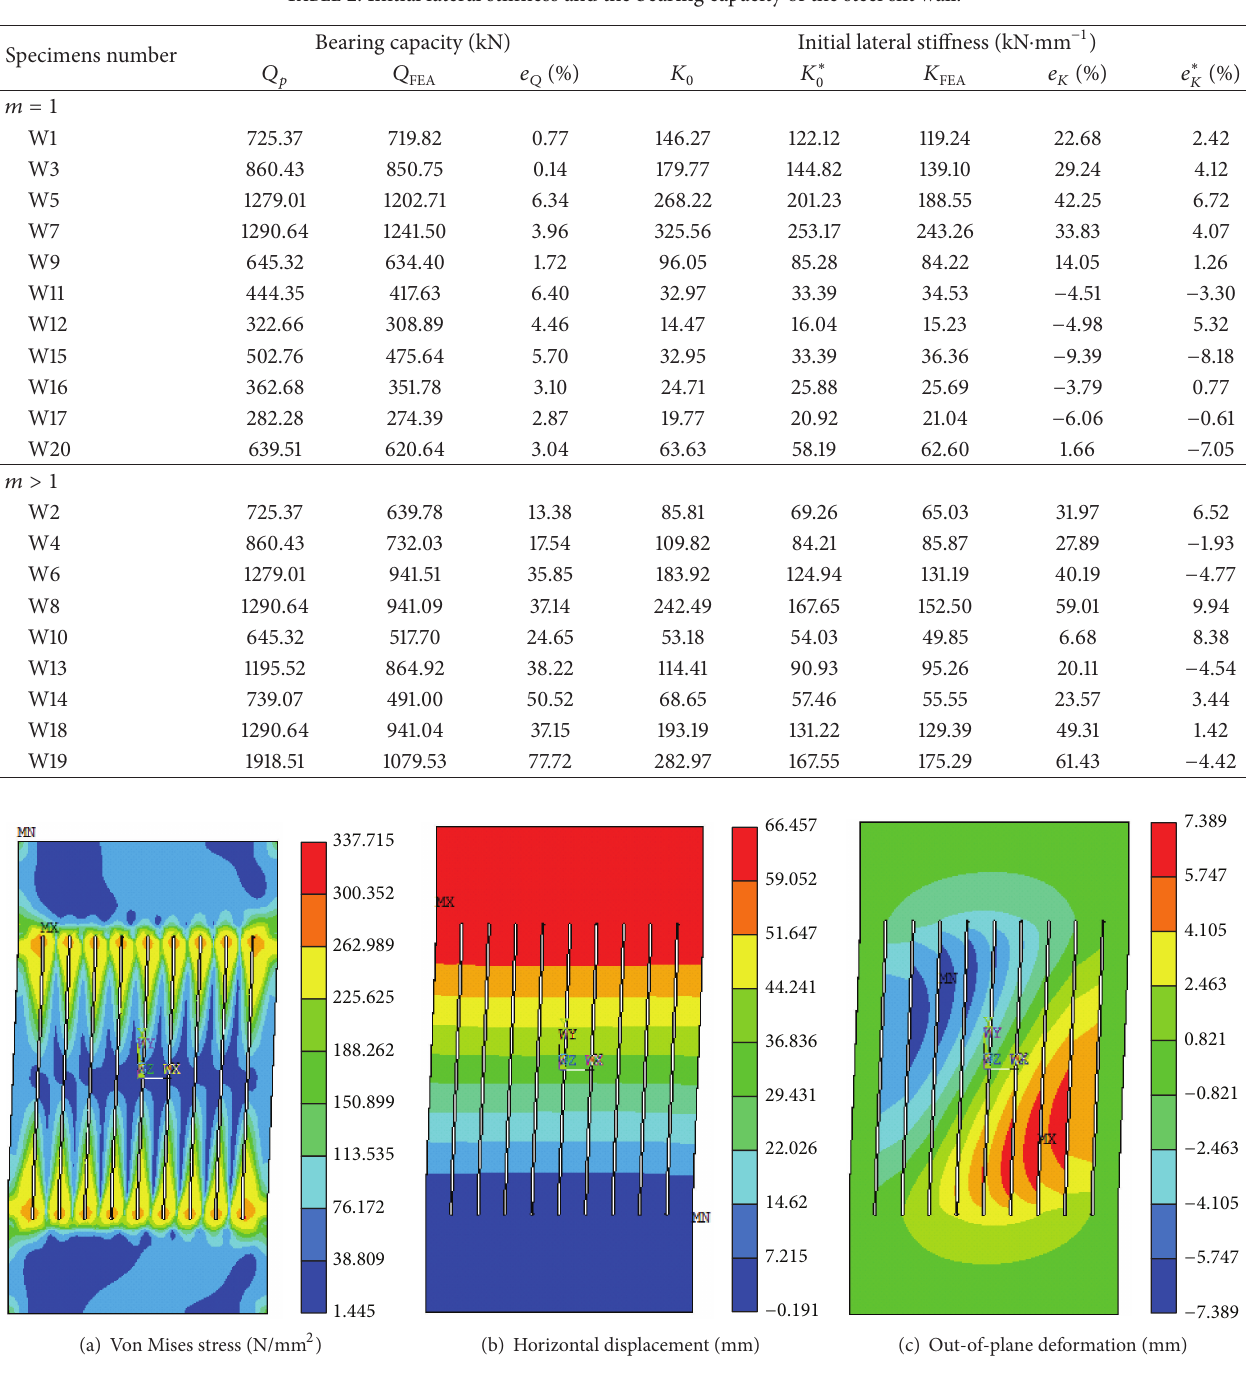
Figure 11: Behavior of the steel slit wall at the ultimate state (Δ/ℎ ≈ 2.2 % )